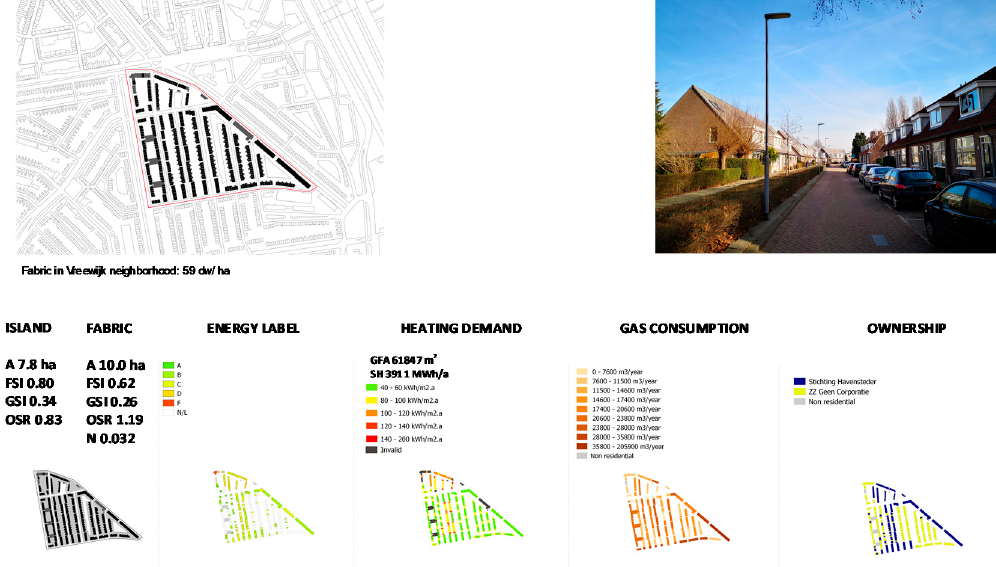
Figure 5. Mapping energy consumption levels and densification on the urban fabric of the Feijenoord district between 1990 and 2010.